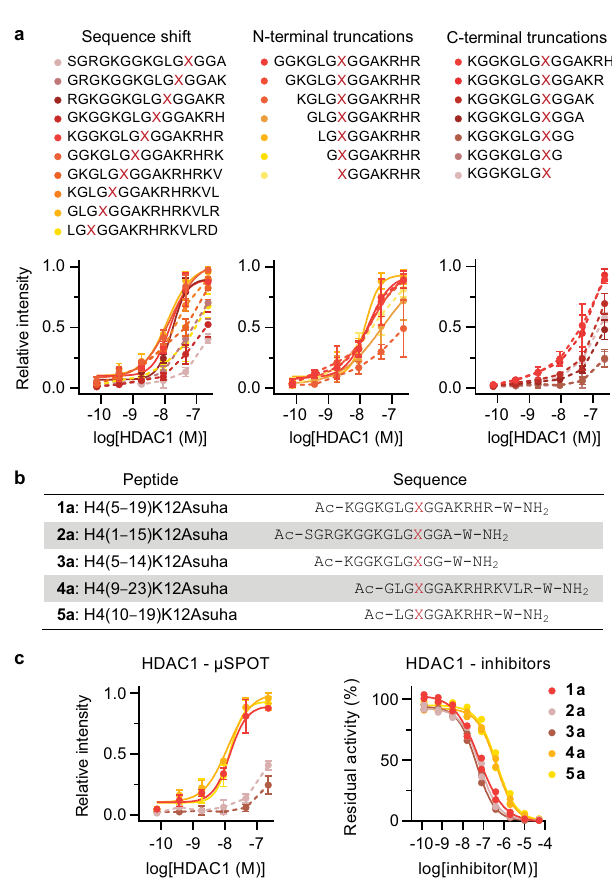
Fig. 4 Application of hydroxamic acid-modi fi ed peptide microarrays for mapping peptide binding requirements. a Fine mapping of relative HDAC1 binding af fi nities in microarray format (data represent mean ± SEM, n = 4 independent experiments). See Supplementary Figs. 4 ‒ 7 for complete data sets for HDACs 1 ‒ 3 and 8. X: Asuha. Source data are provided as a Source Data fi le. b Resynthesized peptide sequences including the parent peptide ( 1a ), two frame-shifted sequences ( 2a , 4a ), a C-truncated sequence ( 3a ), and a N-truncated sequence ( 5a ). c Comparison of the inhibitory curves of resynthesized peptides 1a ‒ 5a with their corresponding microarray binding curves against HDAC1 (microarray data represent mean ± SEM, n = 4 independent experiments; inhibition data represent n = 2 independent experiments). See Supplementary Fig. 8 for data on HDACs 2, 3 and 8 and for half-maximal inhibition concentrations. Source data are provided as a Source Data fi